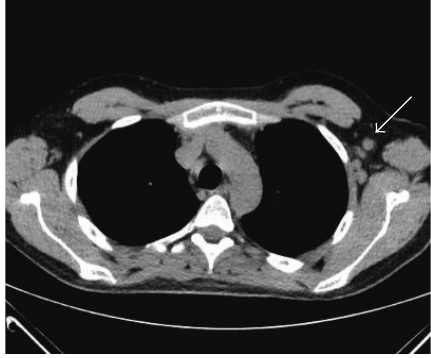
Figure 2: CT scan of thorax. CT of chest showing enlarged axillary nodes (arrow).